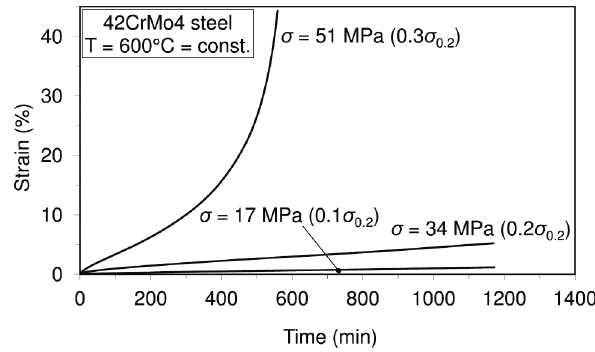
Fig. 4: Short-time creep tests of 42CrMo4 steel at temperature of 400 °C (673 K).